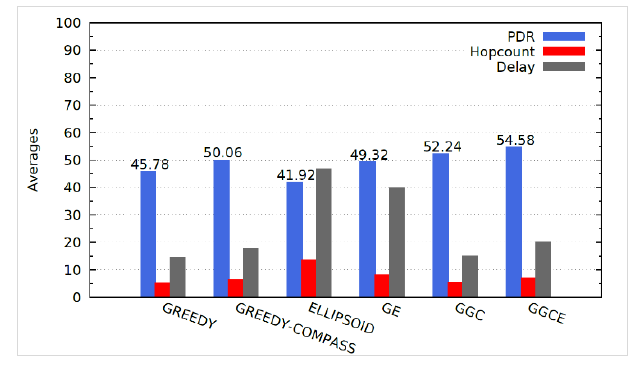
Figure 2. The 200s duration (371 flows) performances for the greedy and the multi-greedy forwarding methods.